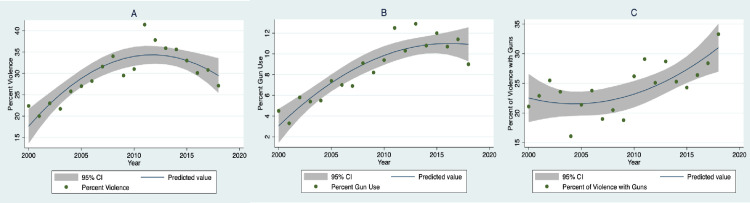
Plots and best fitting trends between study year and percent of TV segments with (A) violence, (B) gun use, and (C) gun use as percent of violence for years 2000 to 2018.